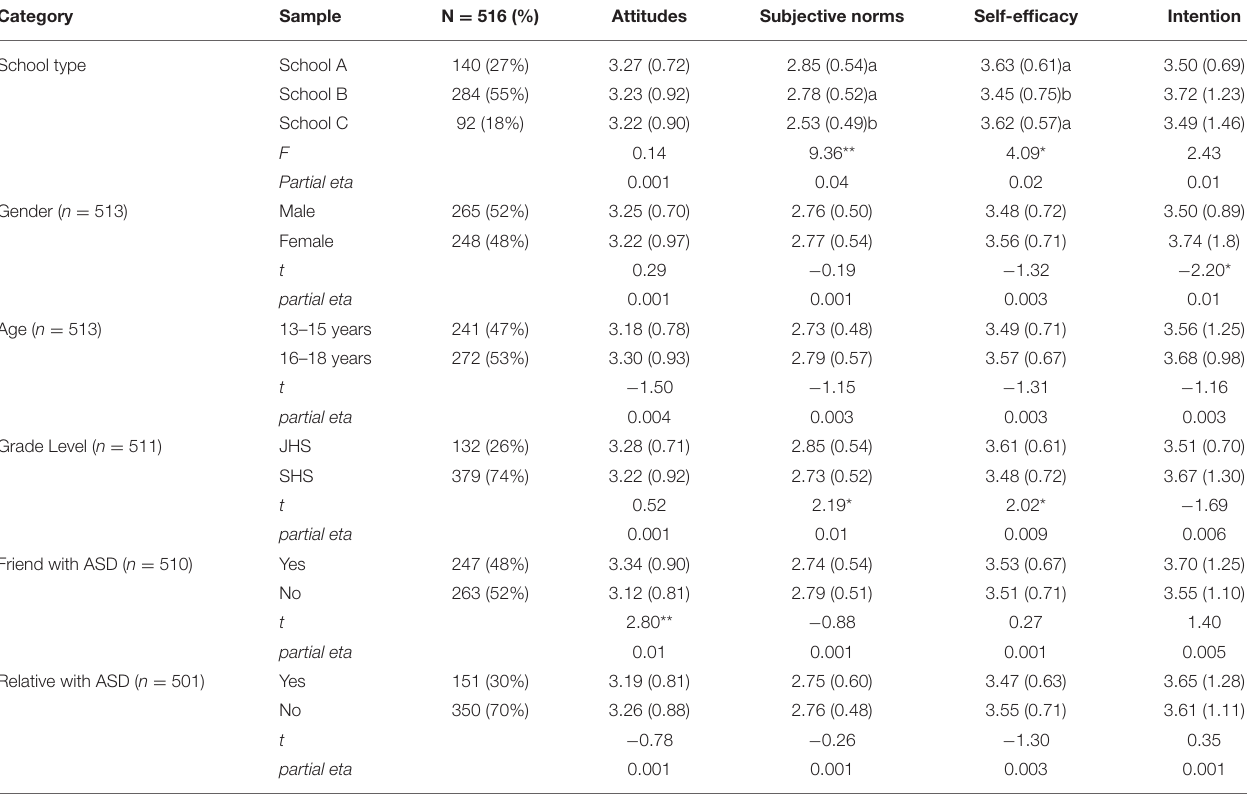
TABLE 1 | Association between demographic variables and intention.